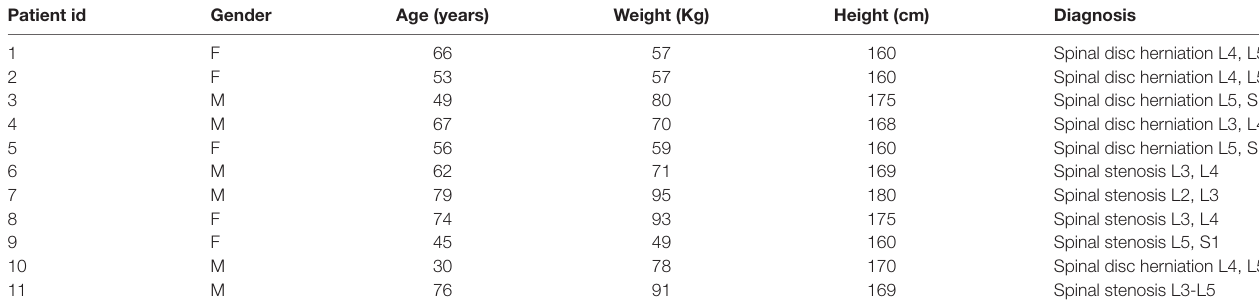
TABLE 1 | Demographic and clinical